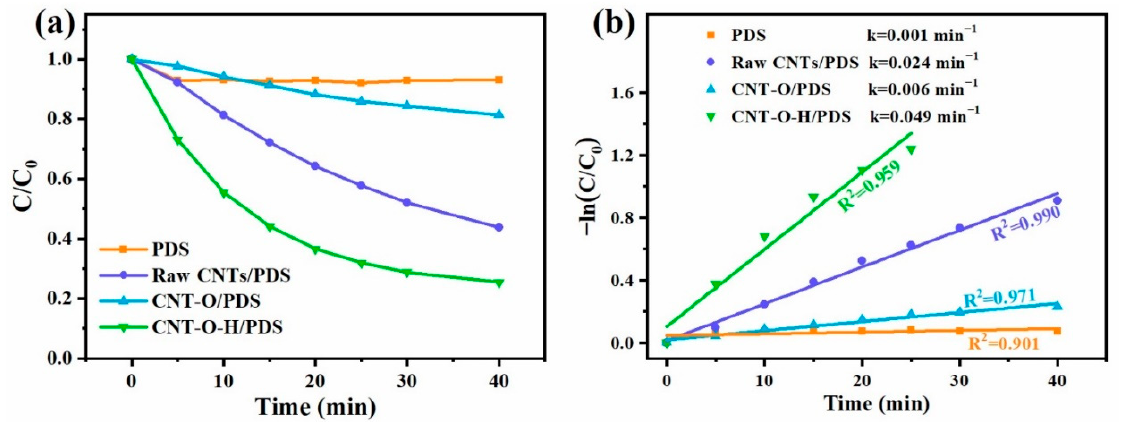
Figure 5. Degradation efficiencies of TC ( a ) and their pseudo-first-order kinetic fitting curves ( b ) in different systems (General conditions: 25 °C, natural pH, 0.2 g/L activator, 0.4 g/L PDS, 50 mg/L TC).